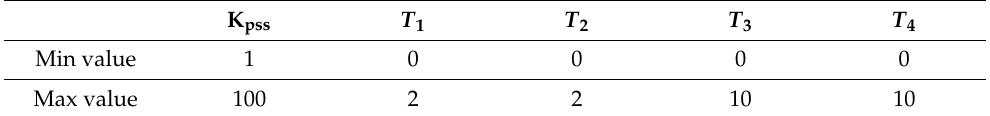
Table 2. The range determined for PSS parameters of the four-machine power system. K